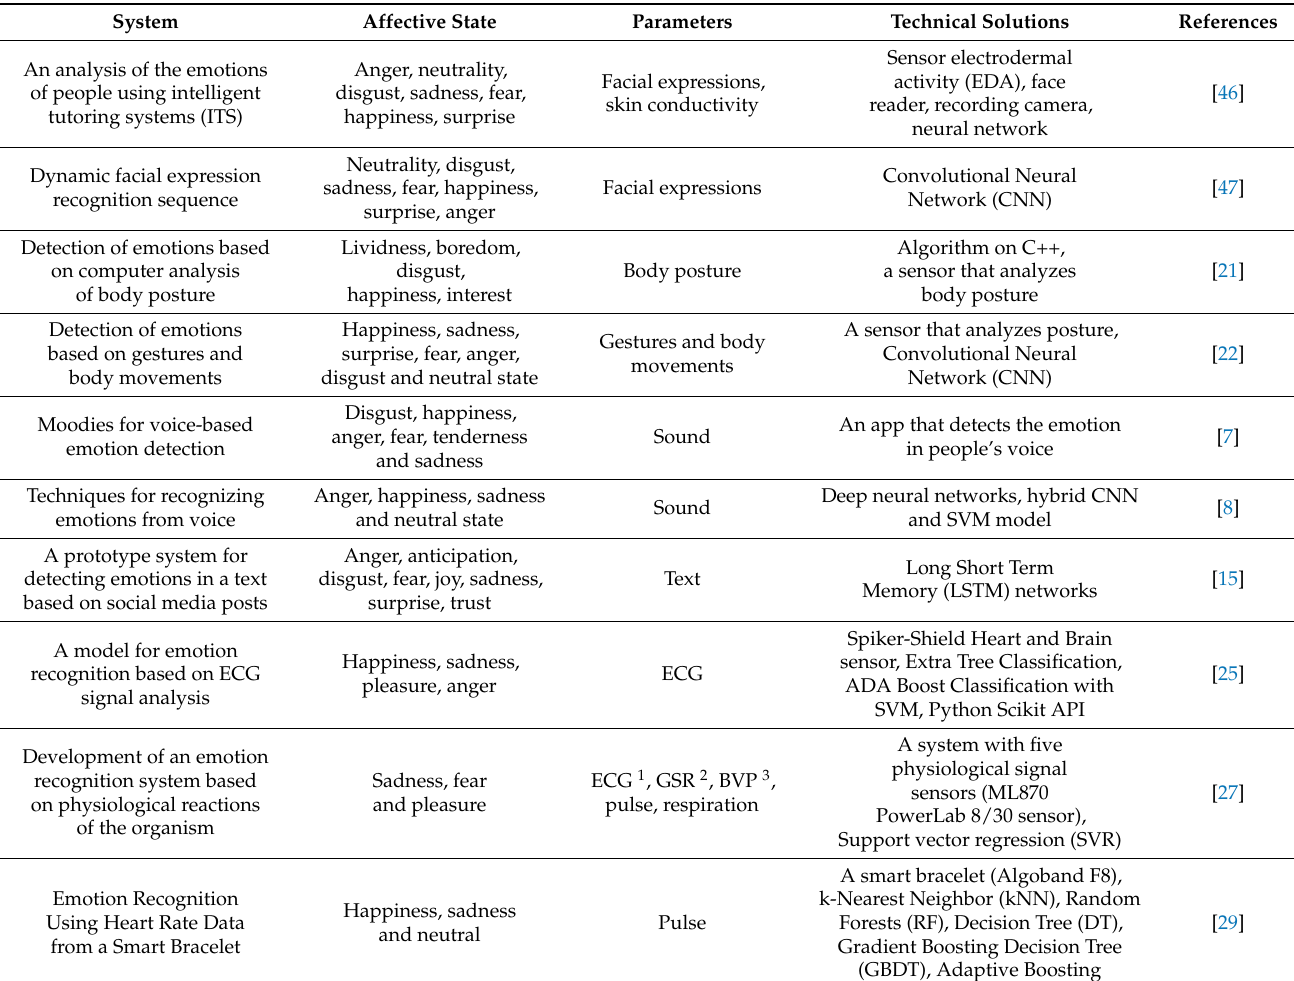
Table 1. Selected systems for automatic recognition of affective